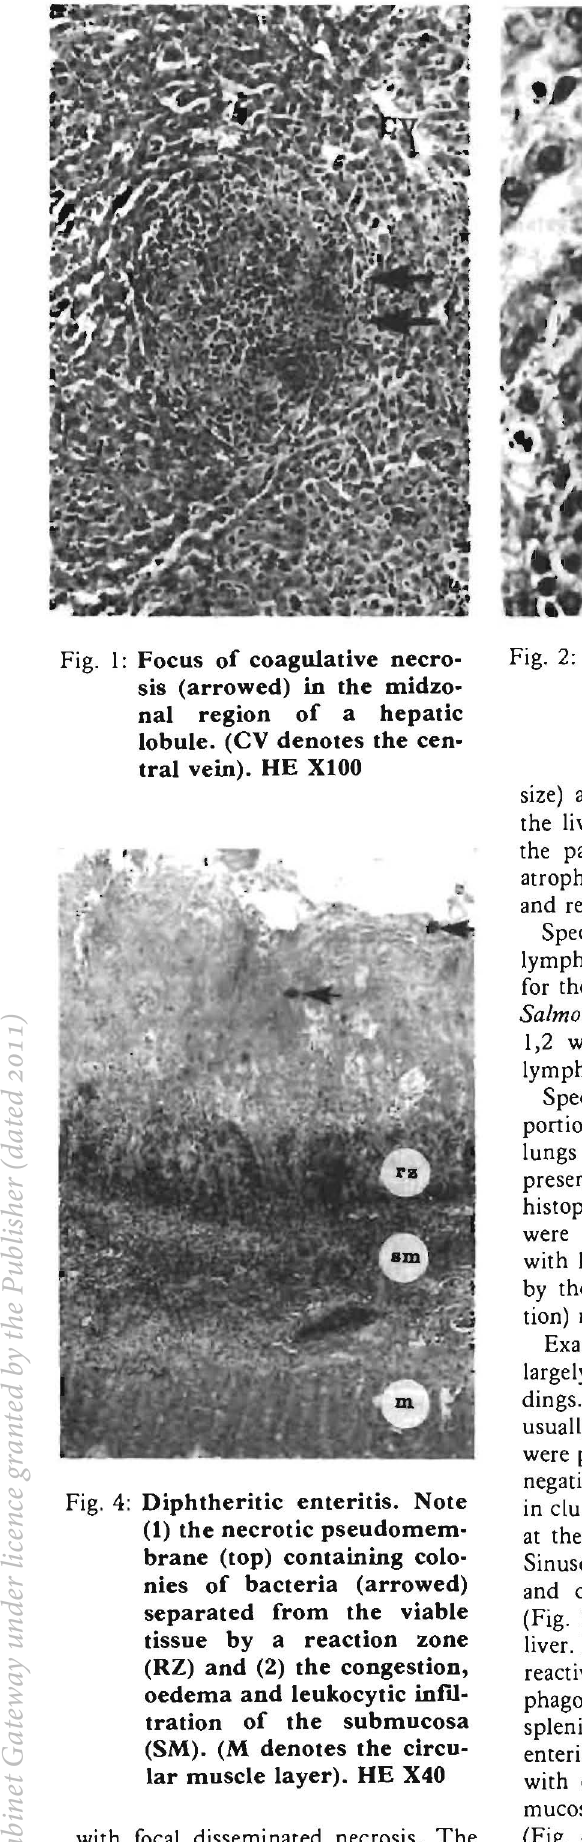
Fig. 2: Bacteria at the periphery of the lesion. Gram X400